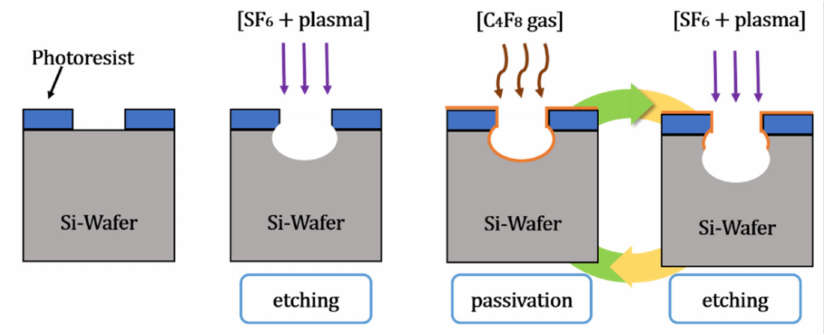
Figure 5. Schematic illustration of the Bosch DRIE